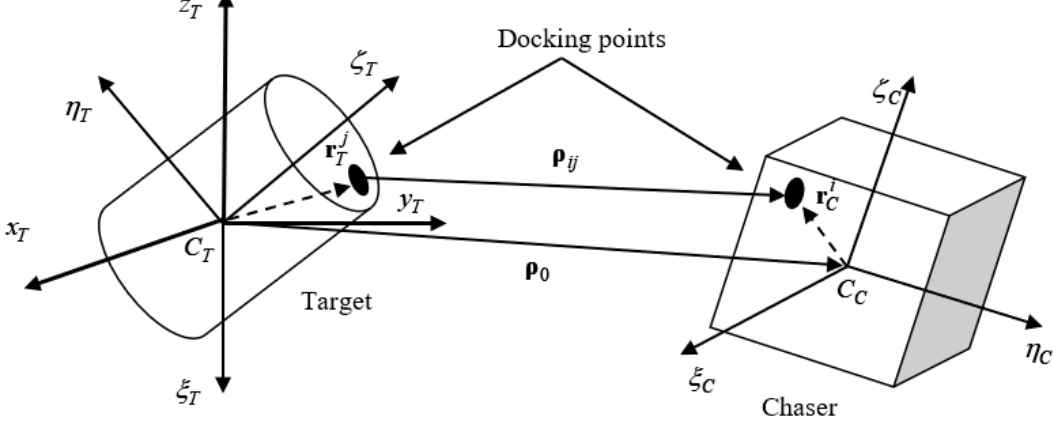
Figure 1. Reference frames of chaser satellite and target object.